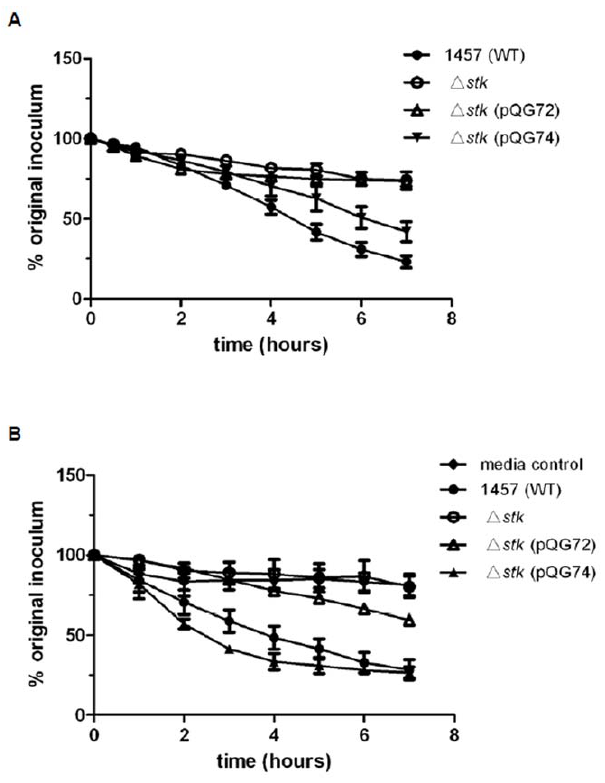
Figure 8. Impact of Stk on cell wall-related phenotypes. A. Triton X-100-induced autolysis of S. epidermidis strains. Cells of the WT, the stk mutant, and the mutant complemented with the kinase domain ( D stk (pQG72)), or PASTA repeated domain ( D stk (pQG74)), were treated with 0.1% Triton X-100. B. Autolysin activity. Bacteriolytic activities of secreted autolysin in the supernatants of stationary phase cultures of the WT, the stk mutant and the complemented strains ( D stk (pQG72) and D stk (pQG74)), were determined using heat-killed S. epidermidis 1457 WT cells as the substrate. TSB was used as media control.